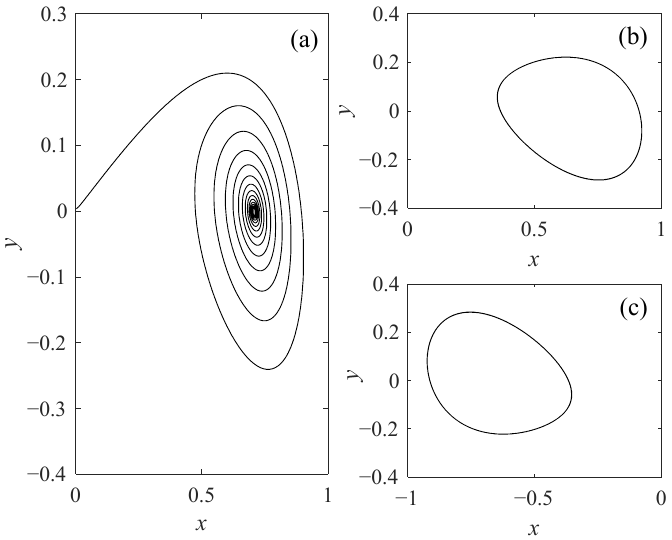
Figure 4. Phase diagrams corresponding to the Hopf bifurcation. ( a ) q = 1.13. ( b ) The limit cycle near the equilibrium F ,0 . ( c ) The limit cycle near the equilibrium